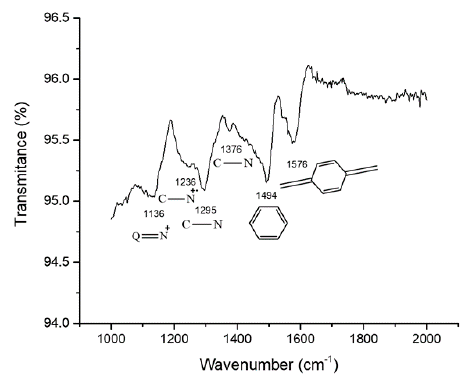
Figure 2. FTIR results of deposited PANI film on